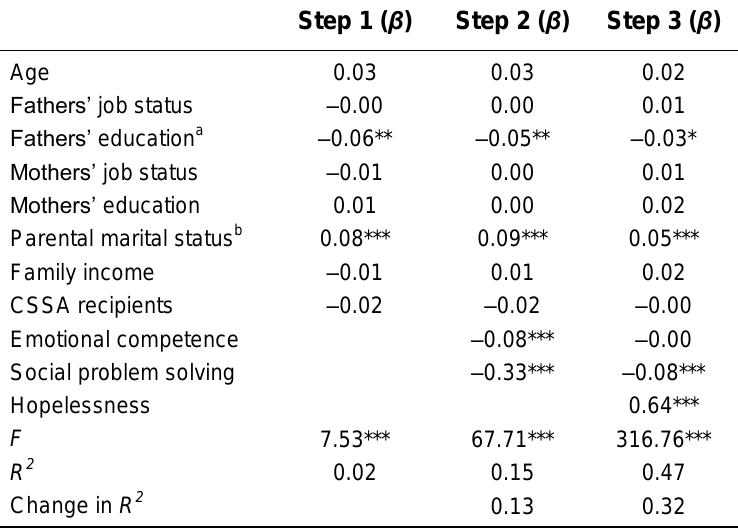
Hierarchical Multiple Regression Analysis for the Prediction of Adolescent Suicidal Ideation in the Total